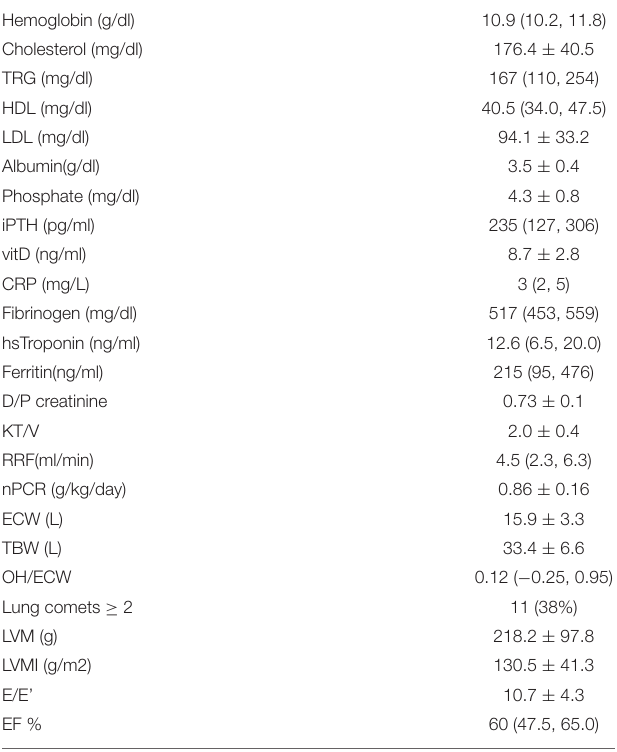
TABLE 2 | Immune cell subpopulations in the control and PD group. Normal